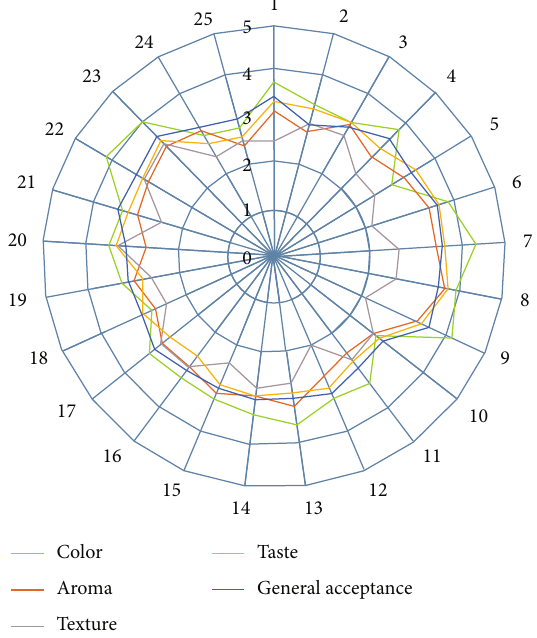
Figure 6: Results of organoleptic test of corn and rice mixture vermicelli (treatments 1 to 25 are presented in Table